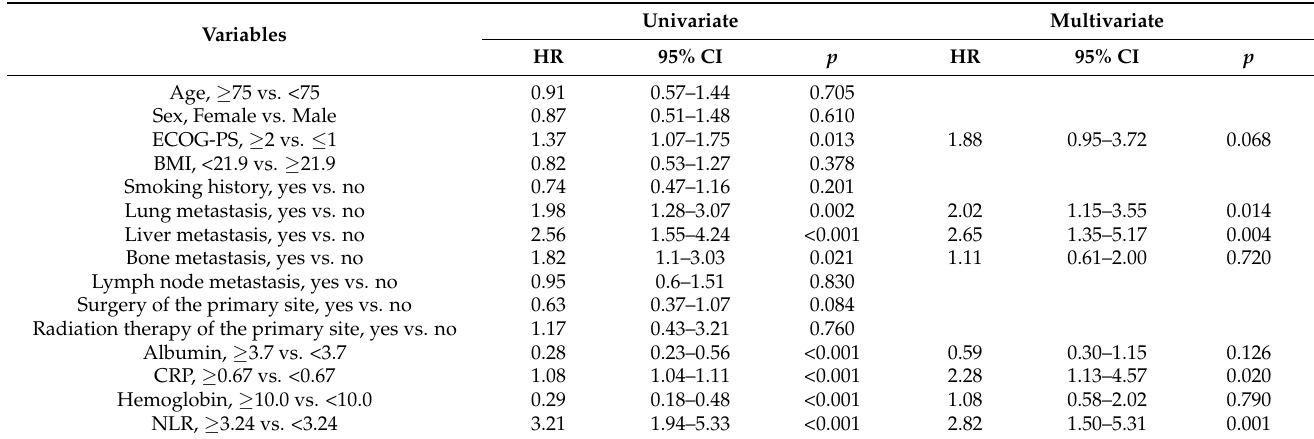
Table 4. Univariate and multivariate Cox proportional hazard regression analysis according to overall